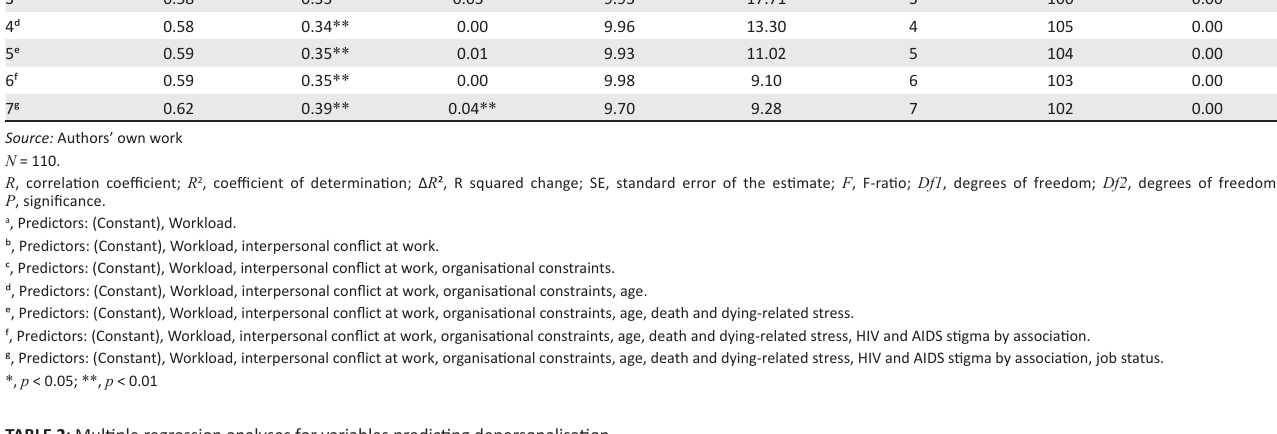
TABLE 2: Multiple regression analyses for variables predicting depersonalisation. Model